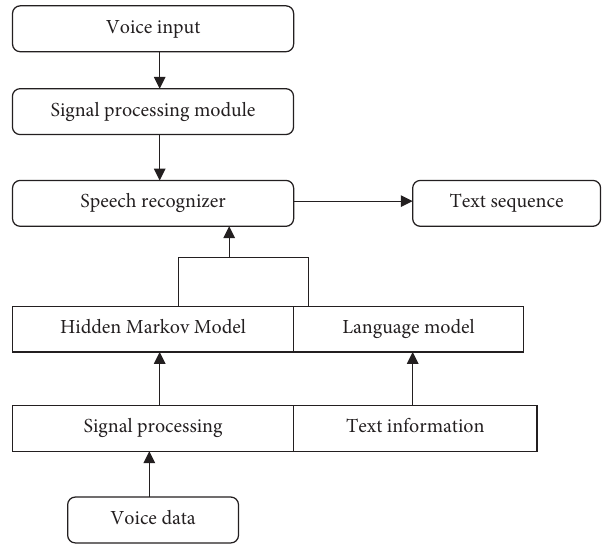
Figure 3: System hardware structure